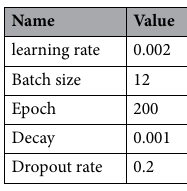
Table 1. Training parameter